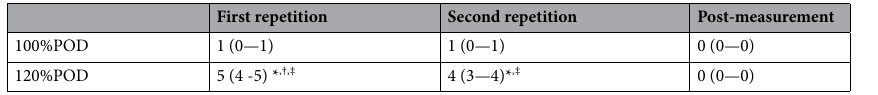
Table 1. Time course of change in NRS. Data were described as median (25%—75%). * p < 0.01 versus value at 120%POD in the post-measurement. † p < 0.05 versus value at 120%POD in the second repetition. ‡ p < 0.01 versus value at 100%POD at the same